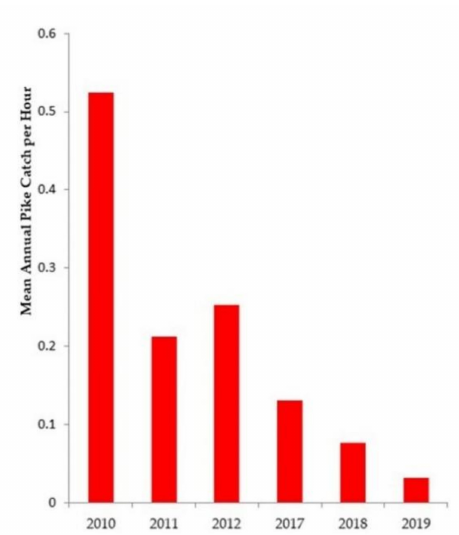
Figure 7. Catch Per Unit E ff ort (CPUE) of pike removed during ADFG pike suppression in Chelatna Lake 2010–2012 and